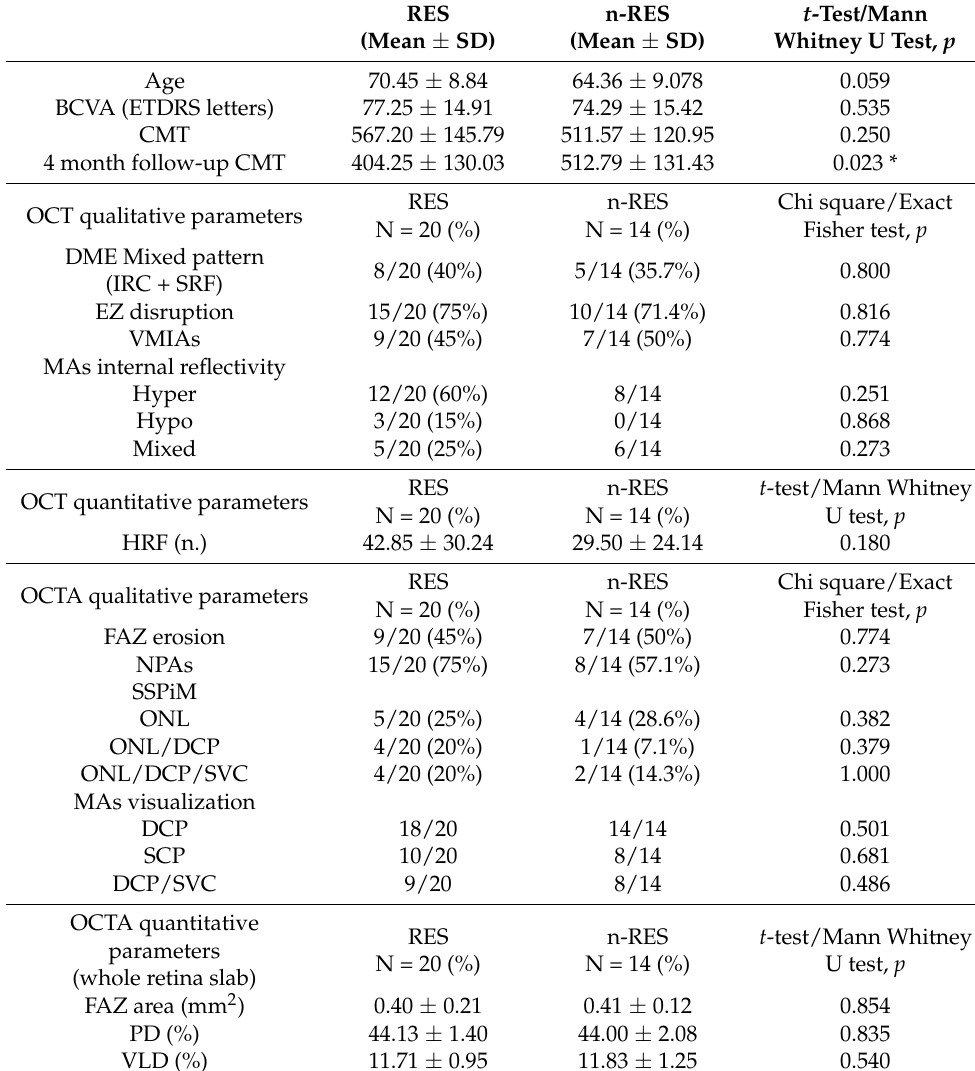
Table 1. Baseline characteristics of responder (RES) and non-responder (n-RES)